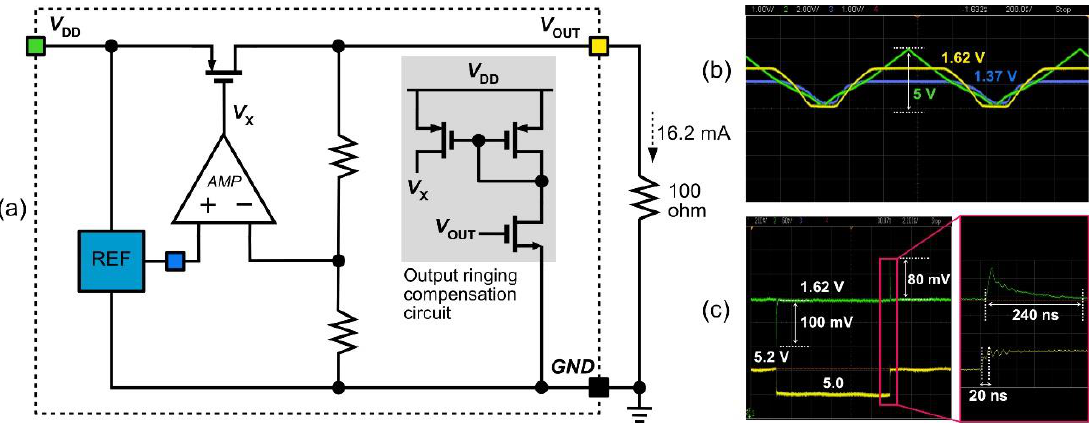
Figure 6. ( a ) Low-voltage-drop regulator (LDO) circuit incorporating the proposed reference circuit; ( b ) measured line-transient responses; and ( c ) measured overshoot and undershoot voltages.